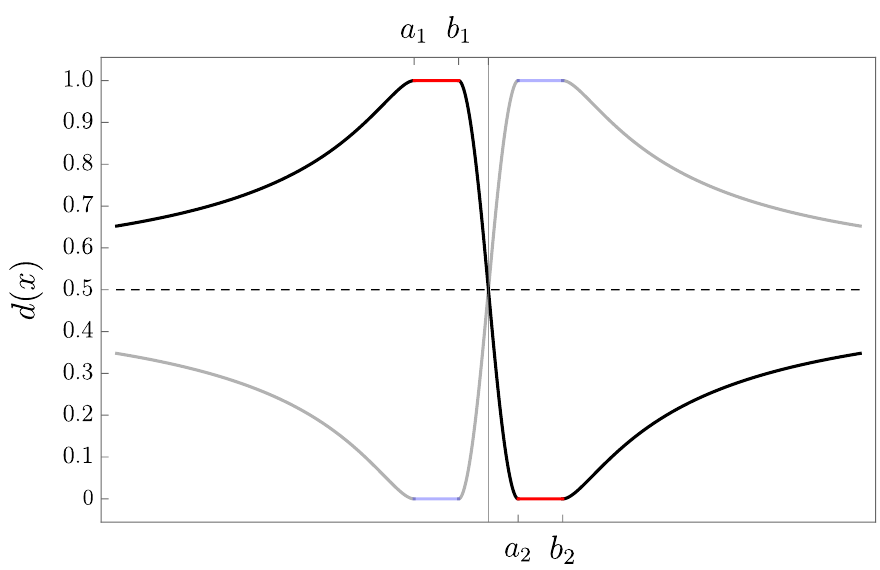
Figure 3 . Spatial density d ( x ) for the type-I factor N AB (black curve and red lines). For x 2 A , d ( x ) = 1, whereas for x 2 B , d ( x ) = 0. Between the two intervals, the density interpolates continuously. As j x j ! 1 , d ( x ) ! 1 = 2. The mirrored gray curve (plus the pale blue lines) corresponds to the density of N 0 | see eq. (1.2) for AB